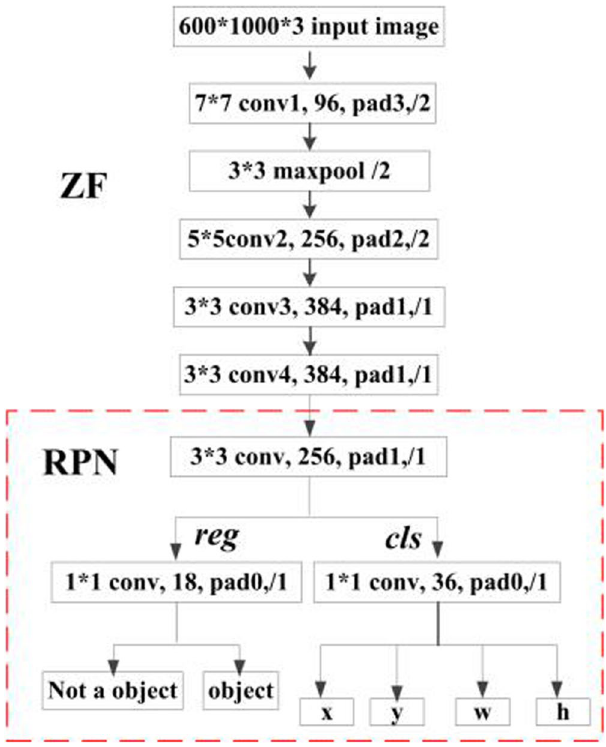
Figure 3. Architecture of ZF and RPN. The top part shows the adopted structure of ZF, which consists of four convolutional layers, conv1 to conv4, and a maxpool layer. The bottom part shows the adopted structure of RPN, which contains a convolutional layer and two output layers, reg and cls